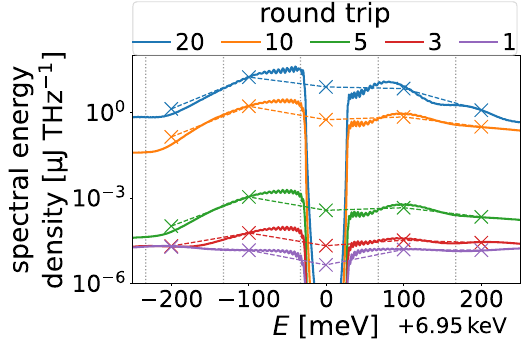
FIG. 5. Evolution of the transmitted spectral energy density versus the number of round trips in logarithmic scale. The spectra are averaged over ten individual bunch trains. The dotted, marked lines show the spectrum which would be observable with an idealized spectrometer with a resolution of Δ E ¼ 100 meV and perfectly centered on E ¼ E c ¼ 6 . 95 keV. Both in the high resolution and in the binned spectrometer data, one can already see a significant rise in the spectral energy density at the third round